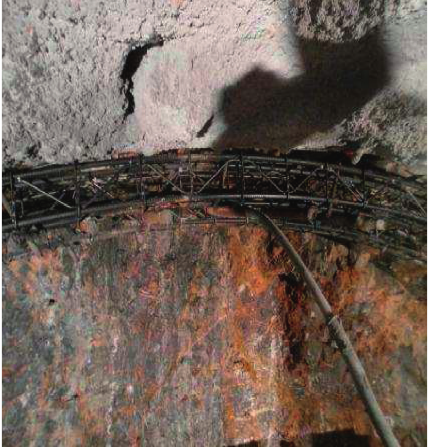
Figure 13: Shotcreting on the vault of tunnel face with Φ 42 ad- vanced small